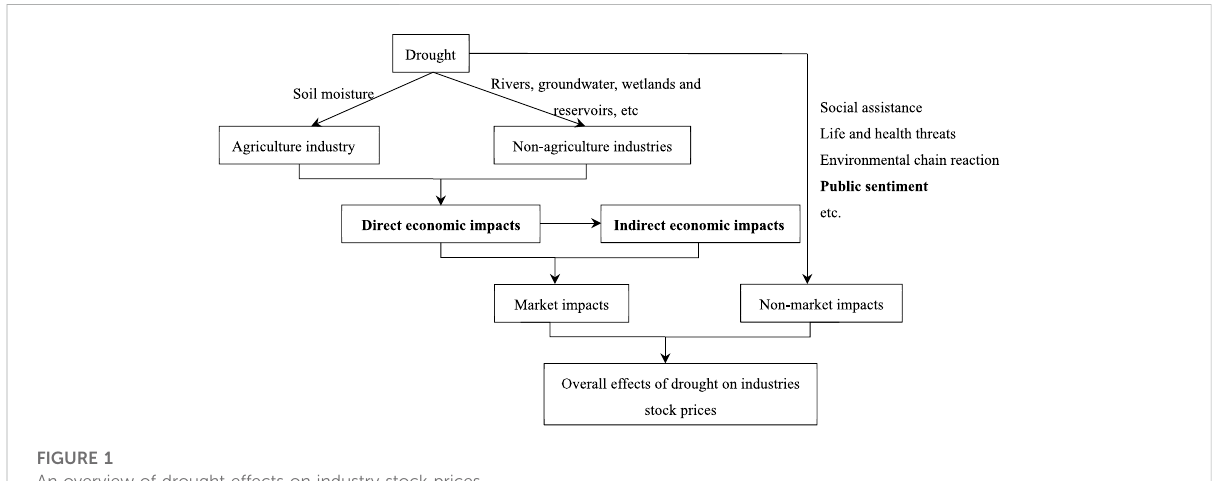
FIGURE 1 An overview of drought effects on industry stock